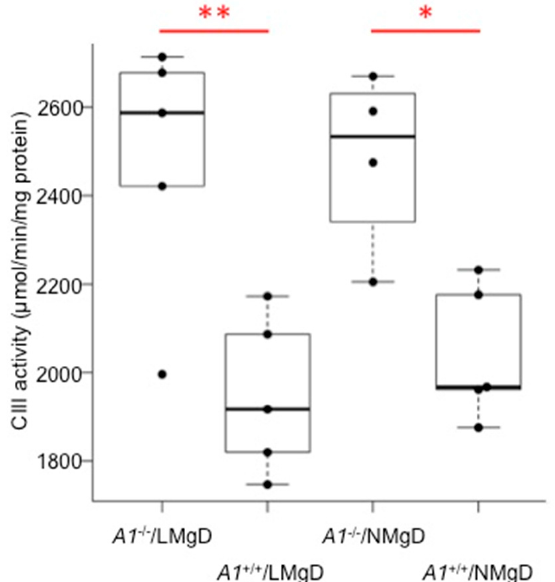
Figure A7. Post-hoc Tukey’s range test / CII. The CII activities presented as box-and-whisker plot overlaid with dot plot; dots represent raw input values for each analyzed group ( Slc41a1 − / − animals on LMgD, Slc41a1 +/+ animals on LMgD, Slc41a1 − / − animals on NMgD, and Slc41a1 +/+ animals on NMgD); ** p < 0.01. Abbreviations: ⦿ , trend towards significance ( p < 0.1); A1 , Slc41a1 ; CII, complex II; LMgD, low Mg diet; NMgD, normal Mg diet.